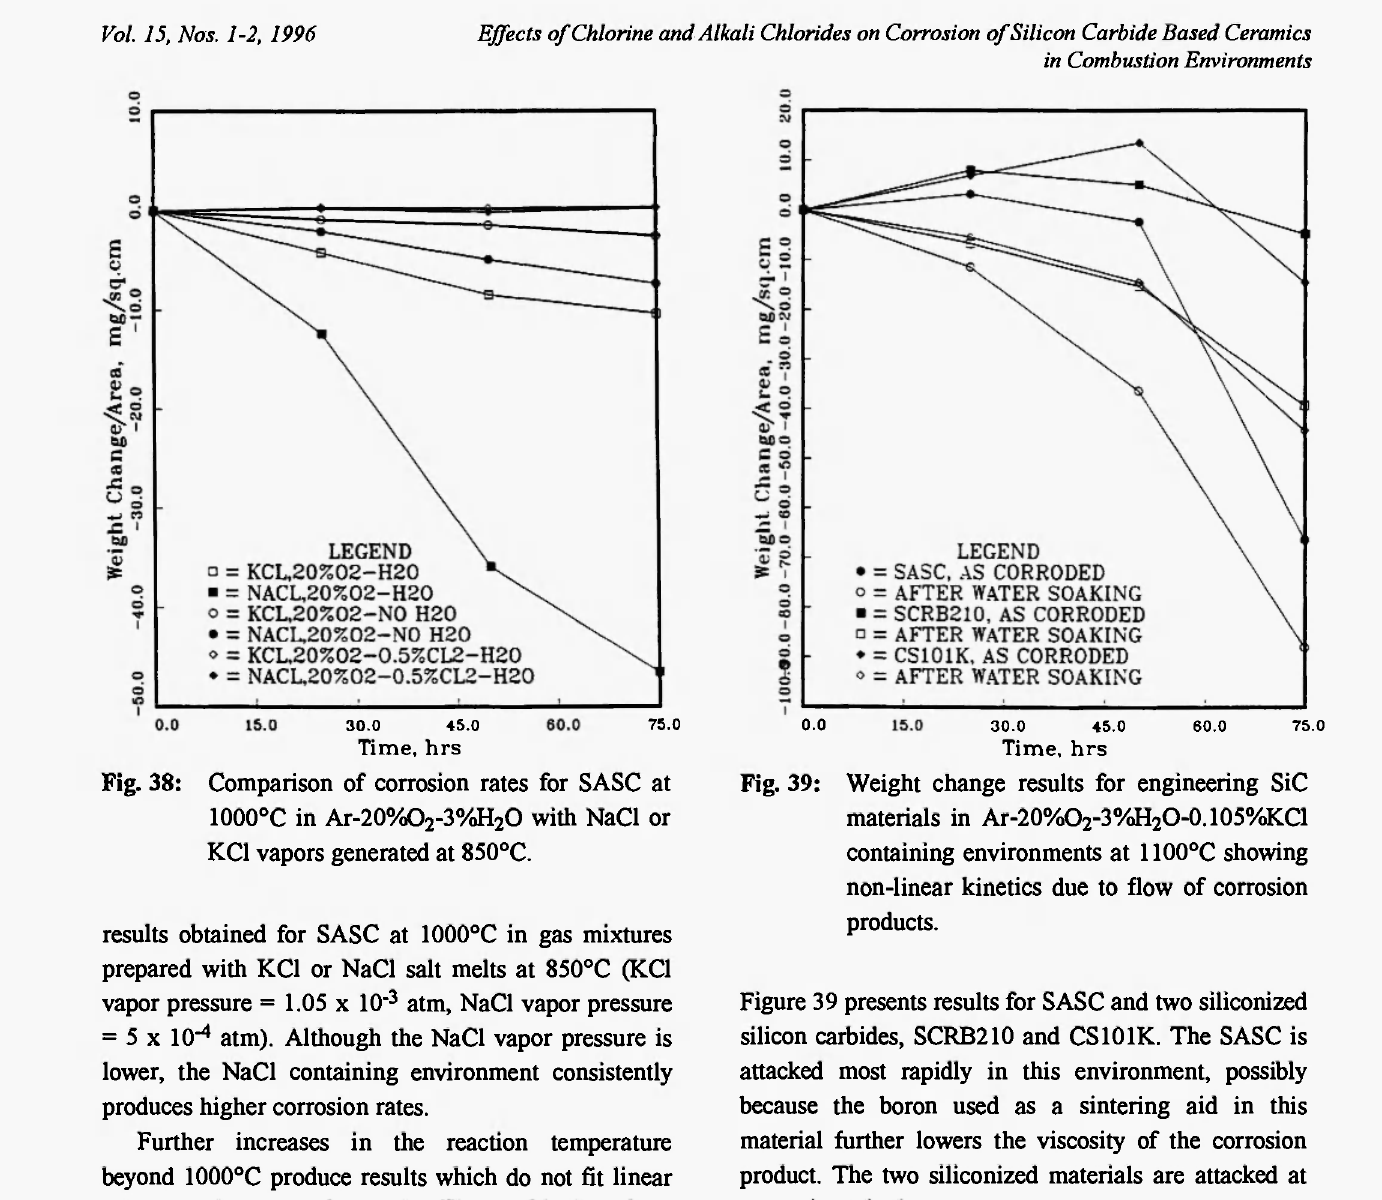
Fig. 39: Weight change results for engineering SiC materials in Ar-20%0 2 -3%H 2 0-0.105%KC1 containing environments at 1100°C showing non-linear kinetics due to flow of corrosion